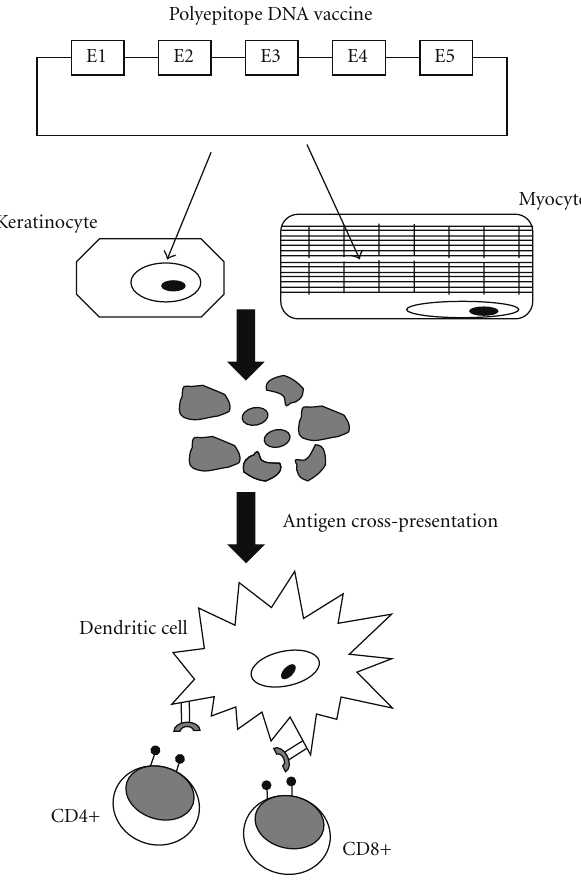
Figure 1: Polyepitope DNA-based cancer vaccines and cross-antigen presentation. After injection of the recombinant polyepitope DNA vaccine into myocyte or keratinocytes, antigenic materials is transferred to dendritic cells (antigen